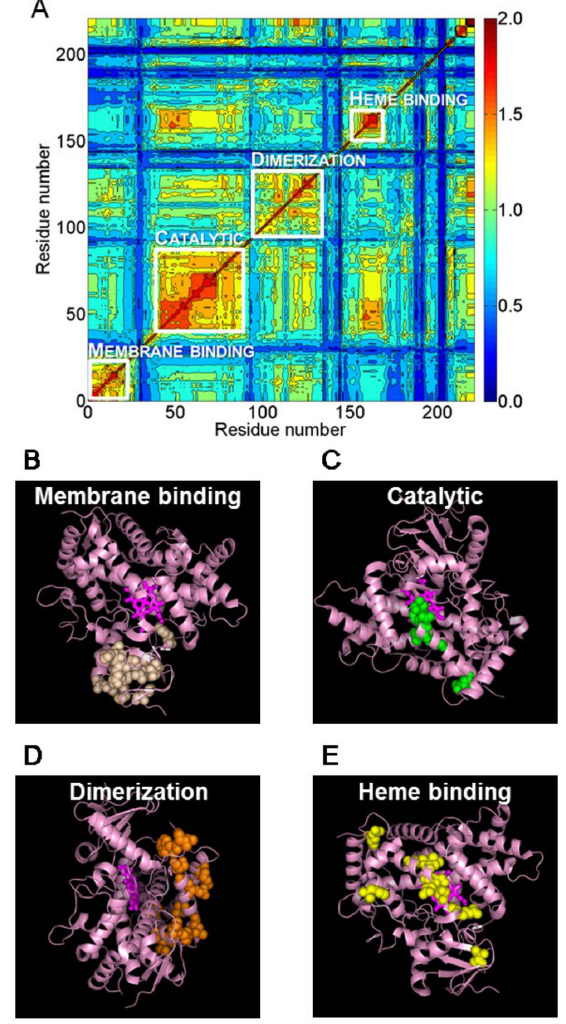
Figure 1. Networks detected by co-evolutionary analysis of CYP2C